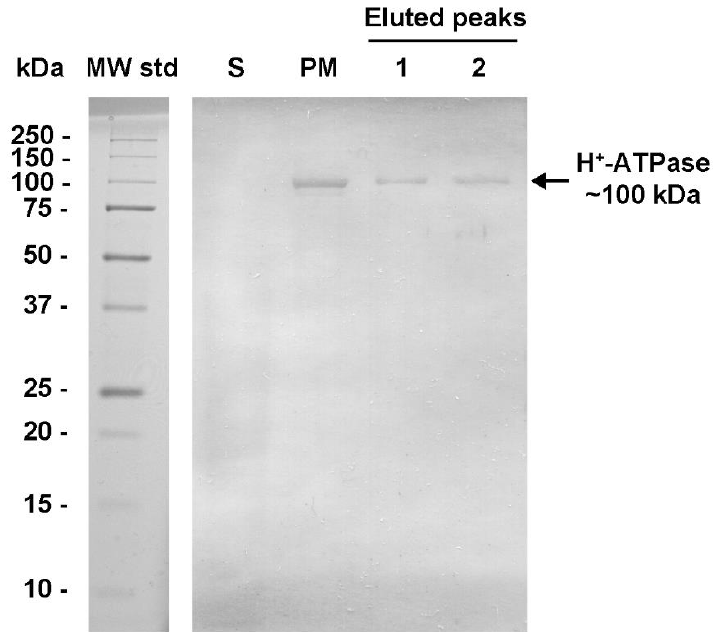
Figure 4. Western Blot of plasma membrane H + -ATPase from K. lactis . The plasma membranes (PM) were isolated from the yeast K. lactis by differential centrifugation, and the H + -ATPase was isolated (Figure 2) by ultracentrifugation on a trehalose gradient [16]. After that, size exclusion chromatography (Superose ® 6 column) was performed and two high absorbing (λ = 280 nm) peaks (Peak 1 and Peak 2) containing the H + -ATPase hexamer were eluted (Figures 2 and 3) when loading 3 mg protein. H + -ATPase samples (PM, Peak 1, and Peak 2) were subjected to SDS-PAGE; a sample of the supernatant (S) from PM purification was included as a negative control. The Western Blot (WB) assay was performed after protein electrophoretic transfer from the denaturing gel to a PVDF membrane and immunoblotted using polyclonal antibodies generated against the recombinant C-terminal domain of H + -ATPase from Saccharomyces cerevisiae . The immunoreactivity was evidenced using the Immuno Blot ® assay kit. The lane of molecular weight standards (MW std) is included and is stained with Coomassie blue.